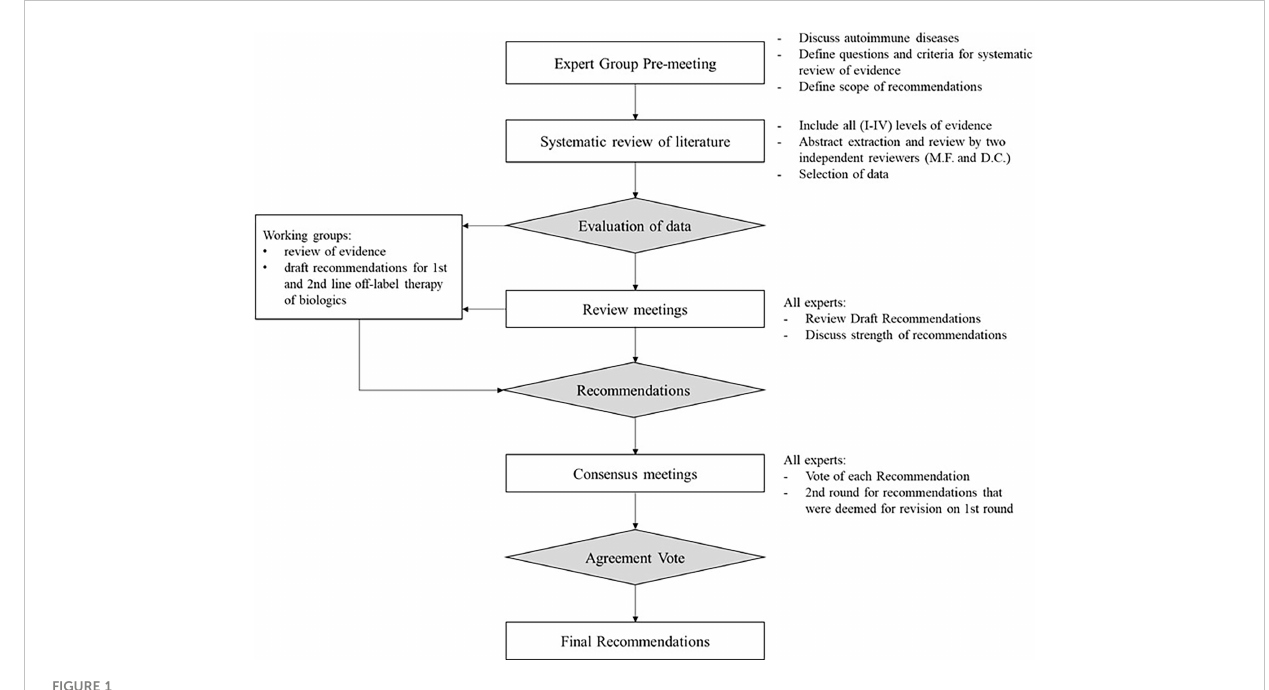
FIGURE 1 De fi nition and approval of recommendations – fl